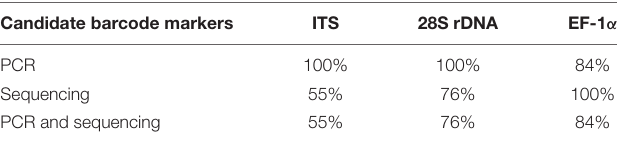
TABLE 1 | Success rates of PCR and sequencing of ITS, 28S rDNA, and EF-1 α gene from 13 species of Pleurotus mushroom spawn. Candidate barcode markers ITS